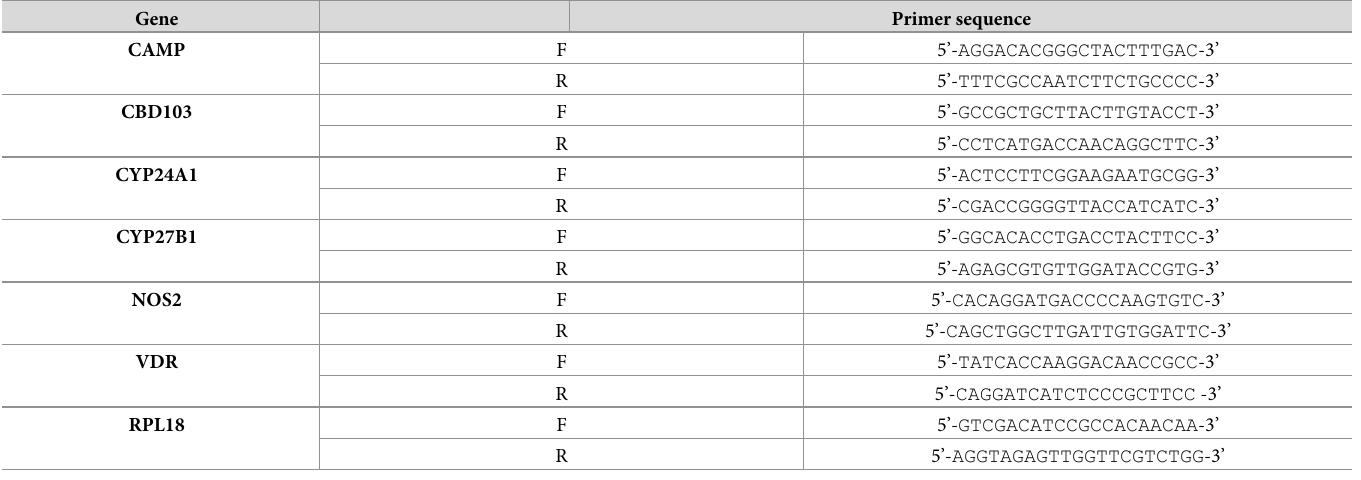
Initials: F and R mean forward primer and reverse primer,